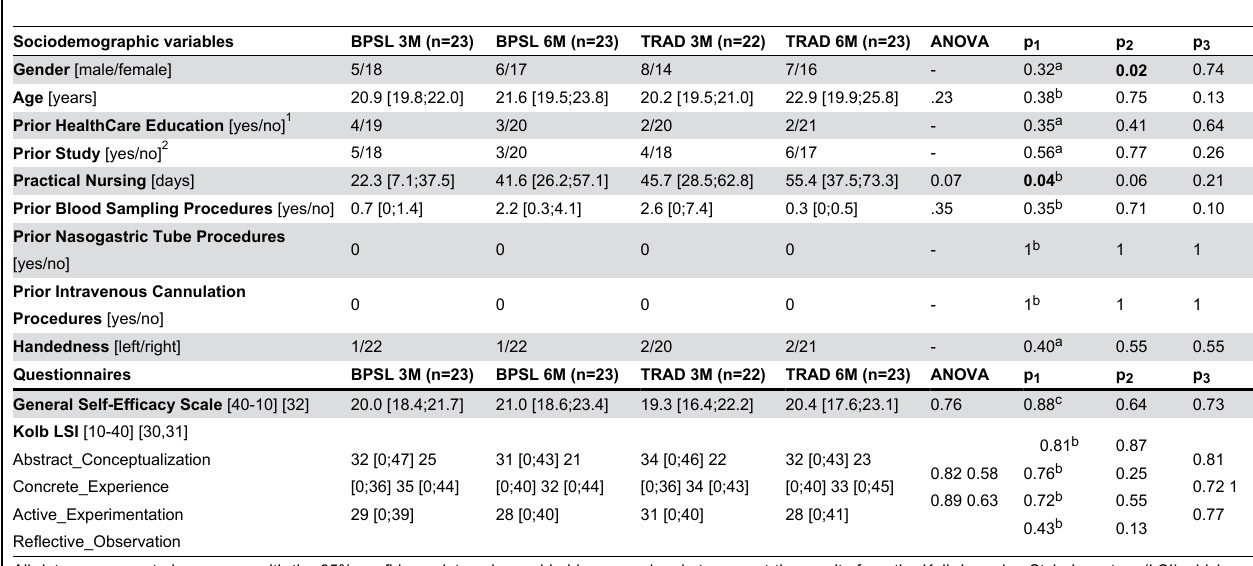
Table 1. Basic socio-demographic characteristics of participants.